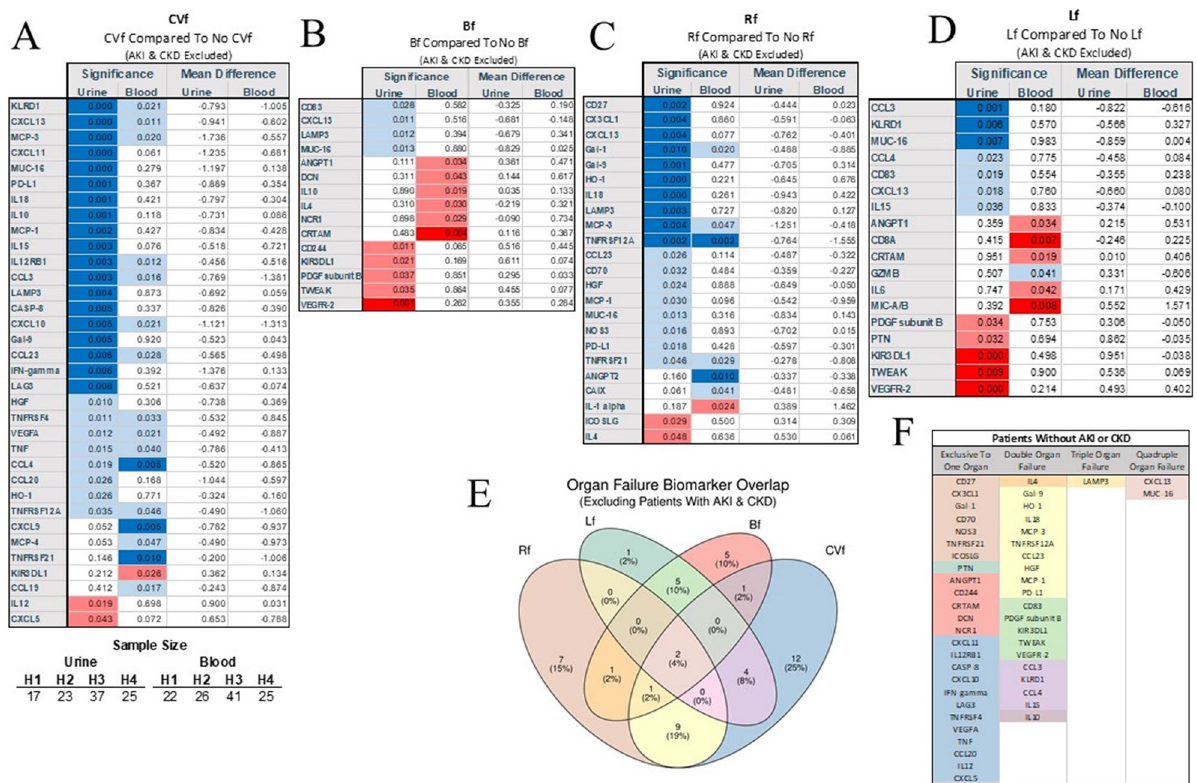
Figure 5. Cardiovascular failure ( A ), utilization of pressors ( B ), respiratory failure ( C ), and liver failure ( D ) produced specific patterns of the injury. Several markers seem to be specific for organ failures ( E & F